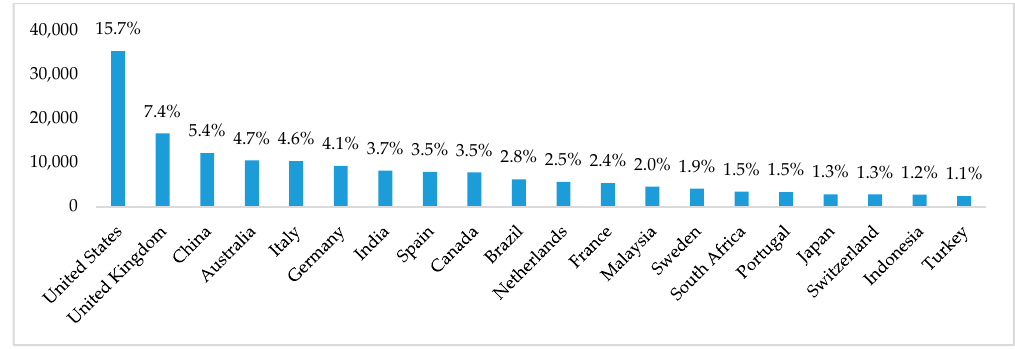
Figure 2. Documents by country published on sustainability between 2011 and 2020.